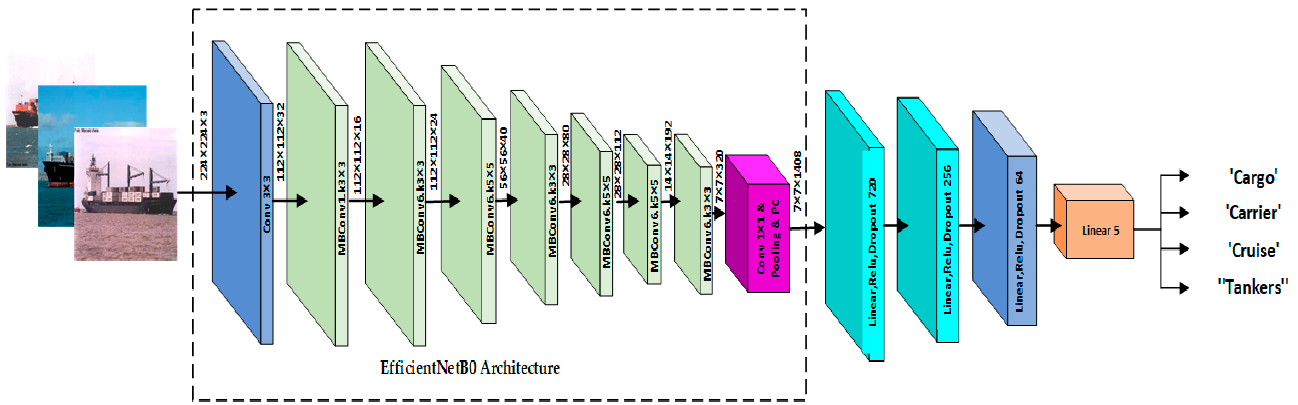
Figure 6. Modified EfficientNetB2 Architecture.